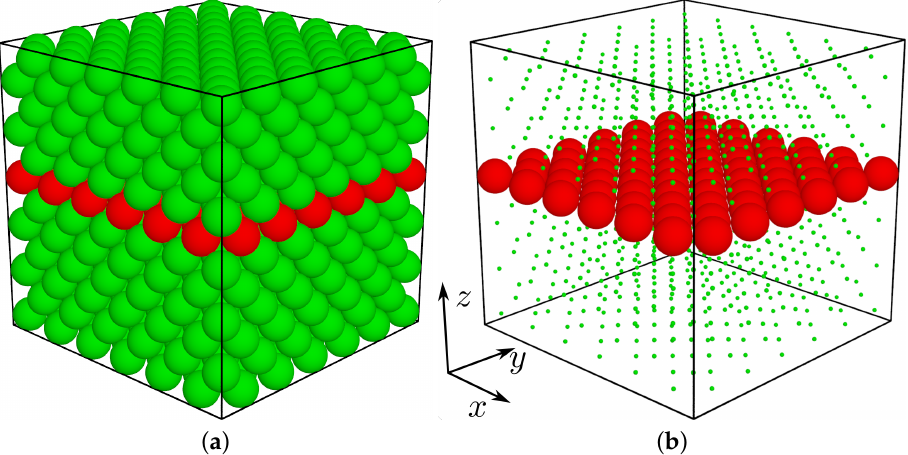
Figure 1. The initial (f.c.c.) unit supercell with the inclusion particles drawn in red ( a ). The positions of the matrix atoms have been scaled down on subfigure ( b ) to reveal the structure of the